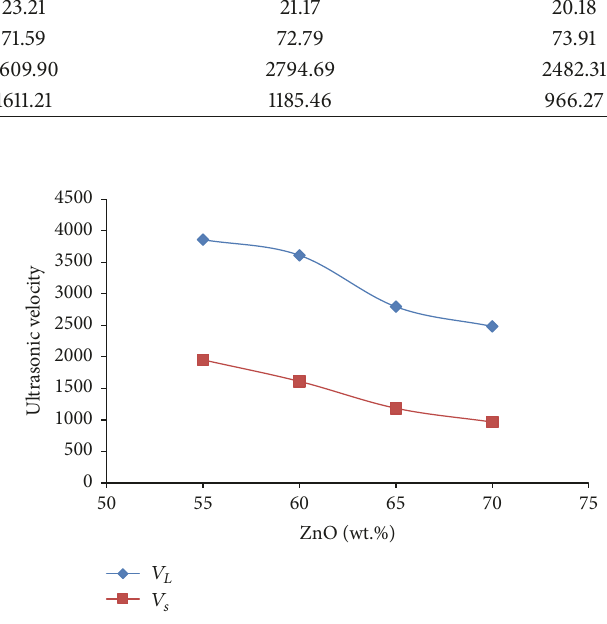
Figure 3: Longitudinal and shear velocity versus wt.% of ZnO in ZnO–SiO 2